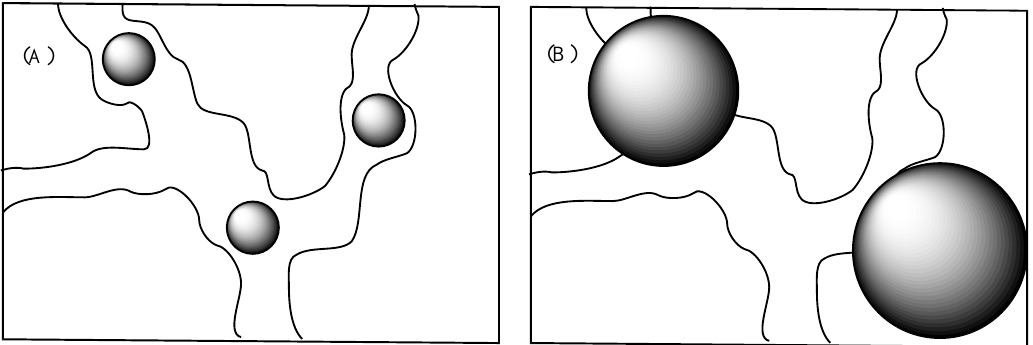
Figure 4. Influence of particle size on water channels in Nafion.